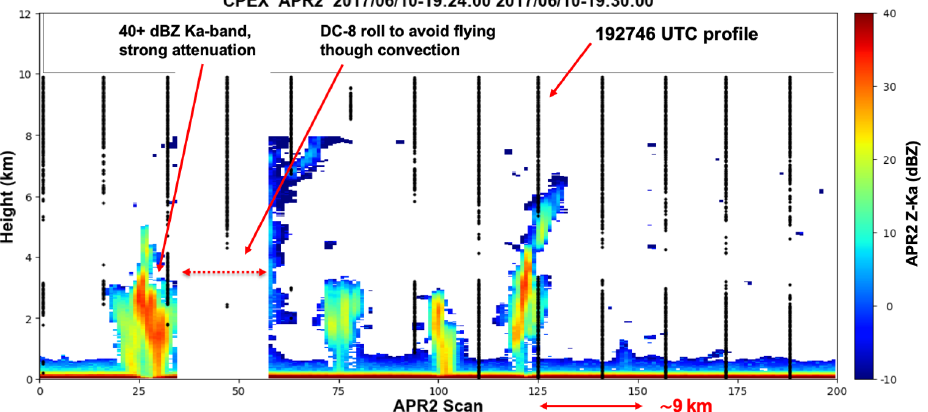
Figure 9. Same format as Fig. 8, but covering only the Box 2 area (19:24–19:30UTC) shown in Fig. 4. DAWN wind profiles are obtained to the surface very close to the growing convection near 19:27:46UTC (near scan